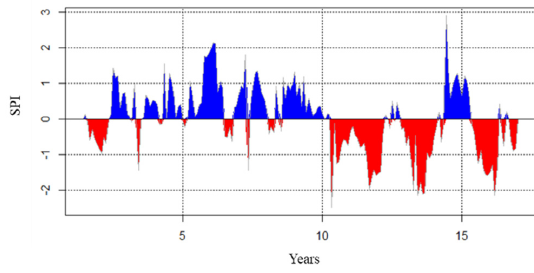
Figure 11. Six-month SPI (years: 2000–2015).